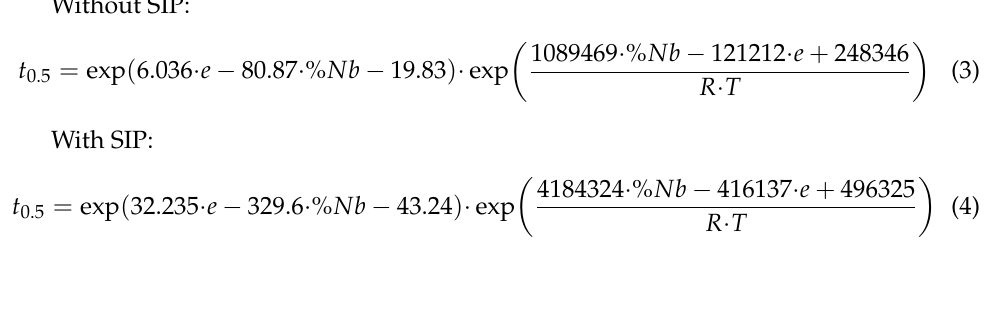
Figure 6. Comparison of measured and calculated values: ( a ) without SIP according to Equation (1) and ( b ) with SIP according to Equation (2).